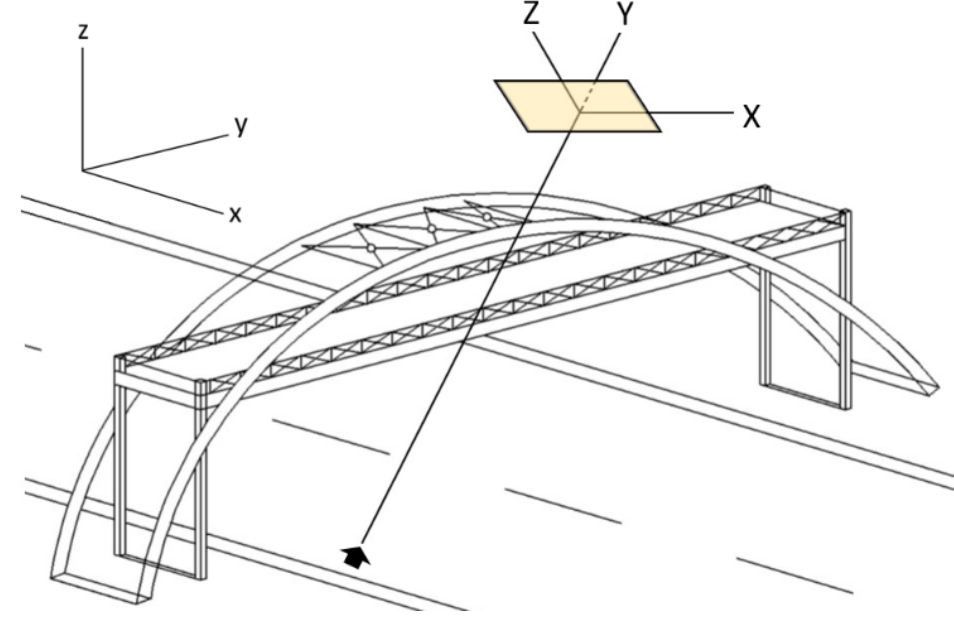
Figure 3. The Cartesian coordinates of the bridge (x, y, z) were transformed into a Cartesian coordinate system (X, Y, Z) defined by the camera image plane (shown as the shaded box). Dynamic displacements along the longitudinal axis y of the bridge were minimal, if any, and the dynamic deformation of the bridge was expressed by deflections confined to the x–z plane. For this reason, a simple linear relationship connected the dynamic deflections of the bridge in the x–z plane with the X–Z plane of the camera image. The black arrow indicates the